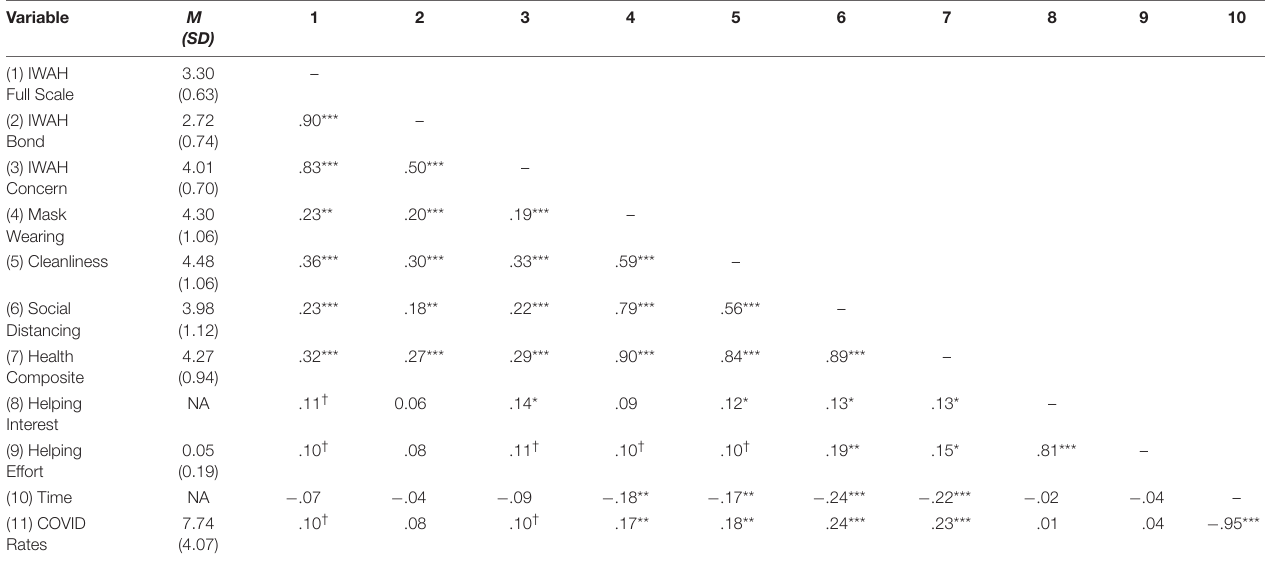
TABLE 1 | Descriptive statistics and bivariate correlations of all primary measured variables in Study 1. Variable